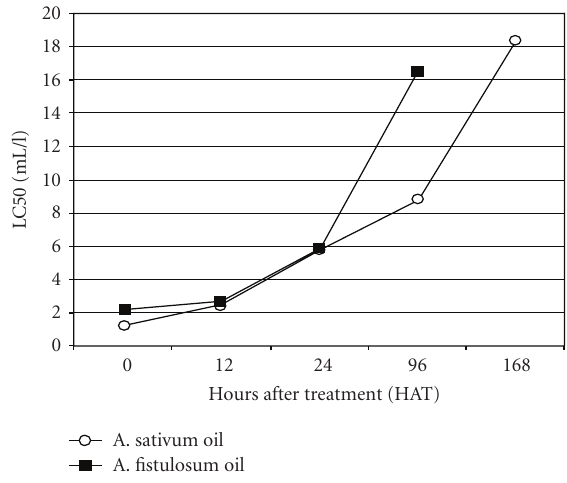
Figure 3: Persistence of test plant essential oils against C . maculatus